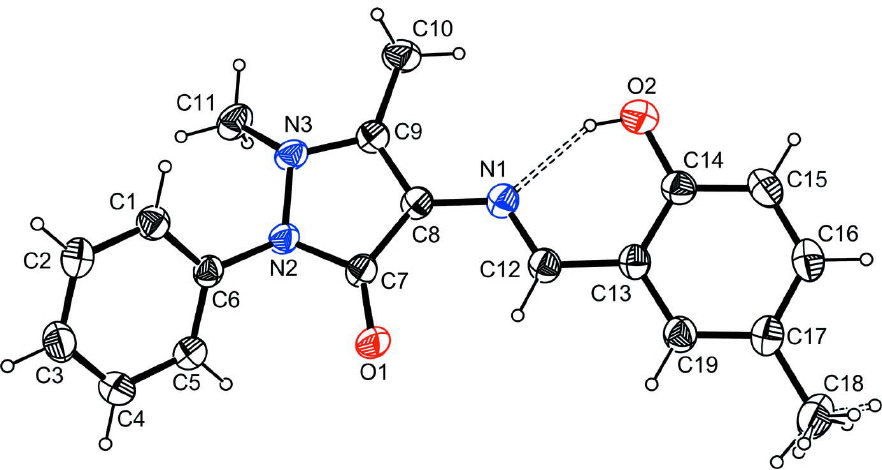
Figure 1 Molecular structure of (I), showing the atom-labelling scheme. Ellipsoids are drawn at the 30% probability level. H atoms are represented as small spheres of arbitrary radii. Hydrogen bond is shown as dashed line.